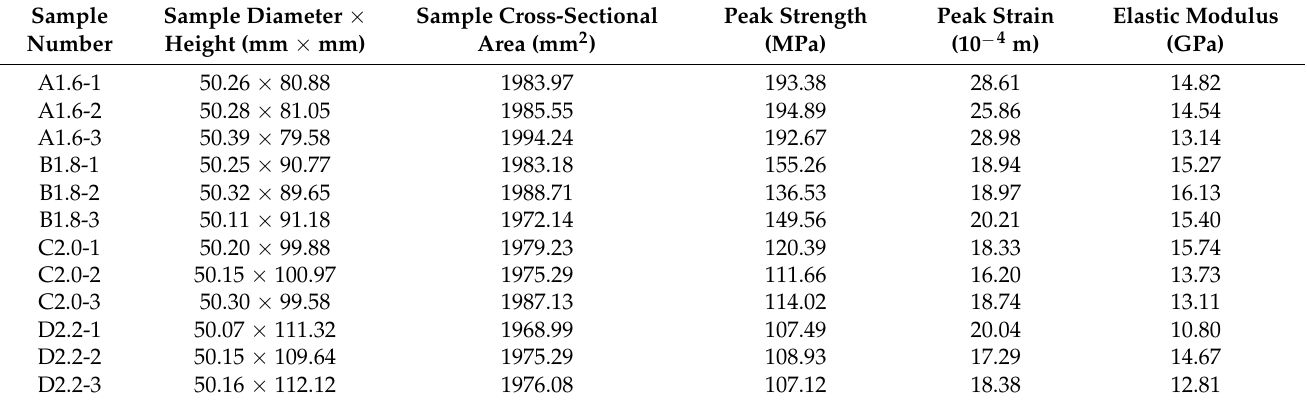
Table 1. Mechanical parameter of rock samples of different ratios of height to